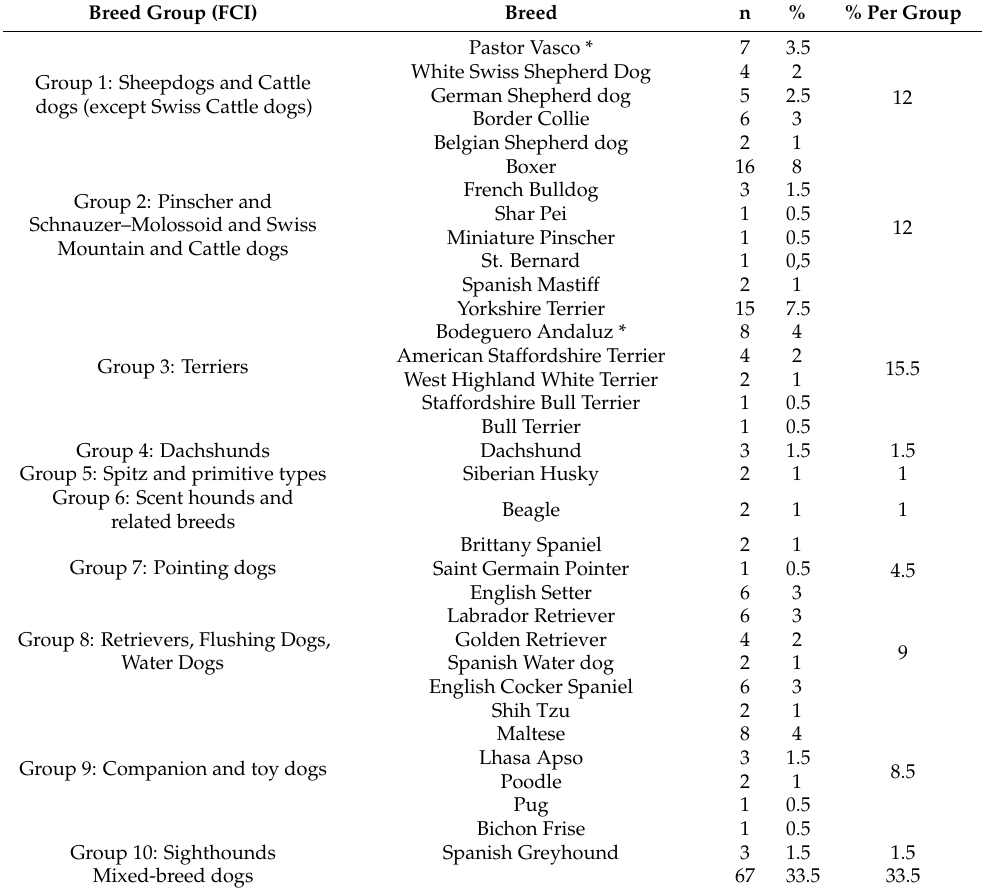
Table 1. Distribution of breeds in the sample deemed as the general Galician canine population. Breed Group (FCI) Breed n % % Per